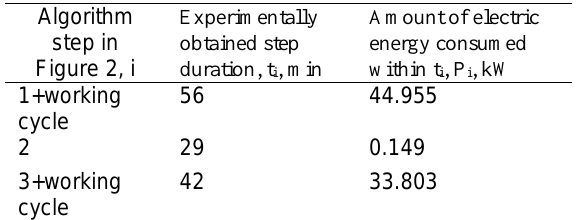
Table 3. Electric power consumption for the algorithm of the 2 nd option of the ECAH operation mode